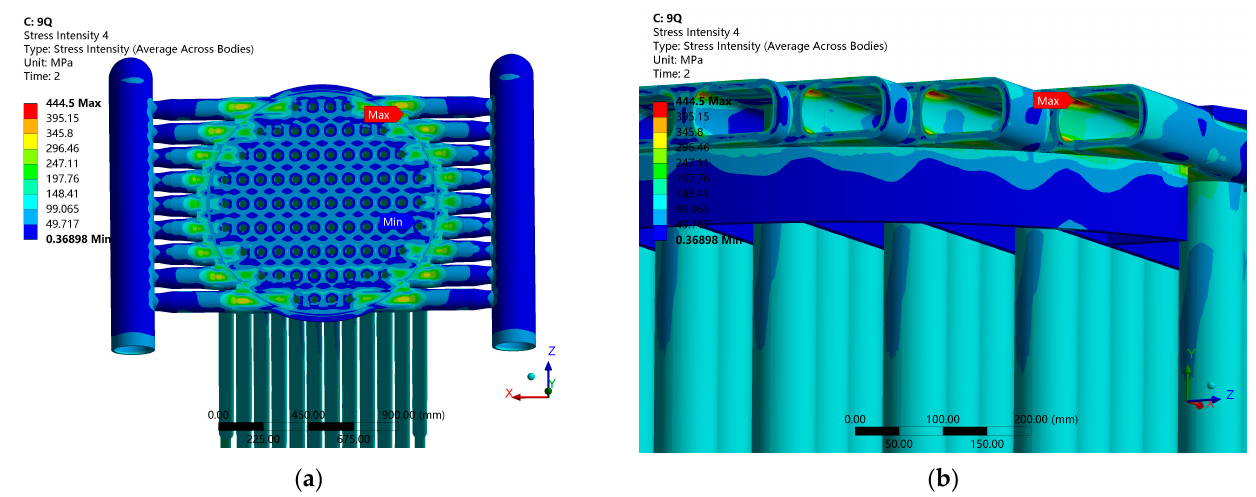
Figure 6. ( a ) Stress intensity distribution and ( b ) maximum stress on the upper flat-round tubesheet under load case 1 with 9 mm pretension of tubes.